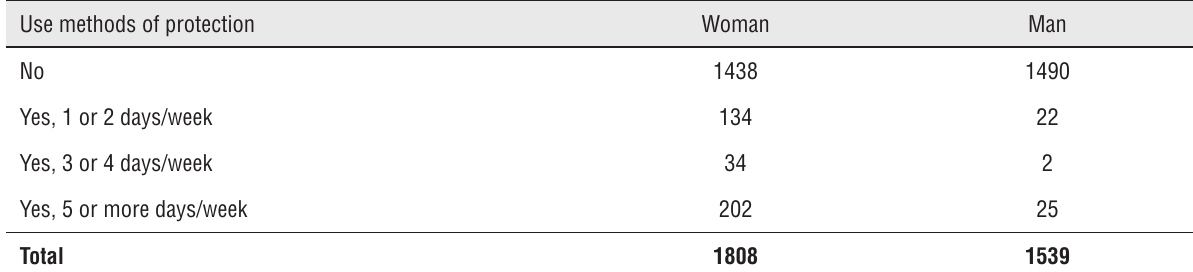
Table 4 - Prevalence of elderly who use methods of protection from urinary